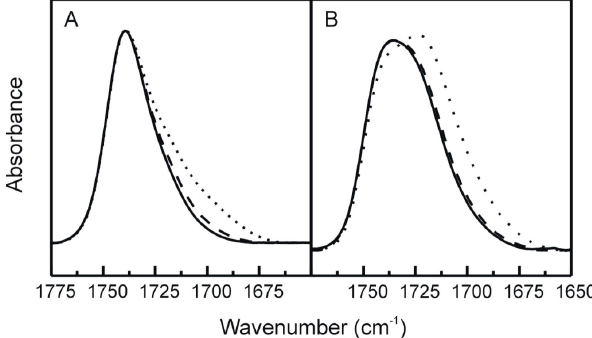
Figure 6. FT-IR ester carbonyl absorption band. Pure DMPE (solid lines), DMPE containing TMCG at 0.07 (dashed lines) and 0.25 (dotted lines) molar fraction, below (25 °C, panel A) and above (57 °C, panel B) the gel to fluid phase transition.